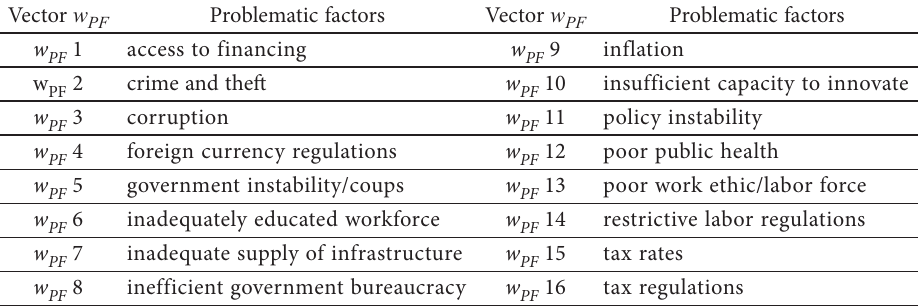
Table 1. The most problematic factors for doing